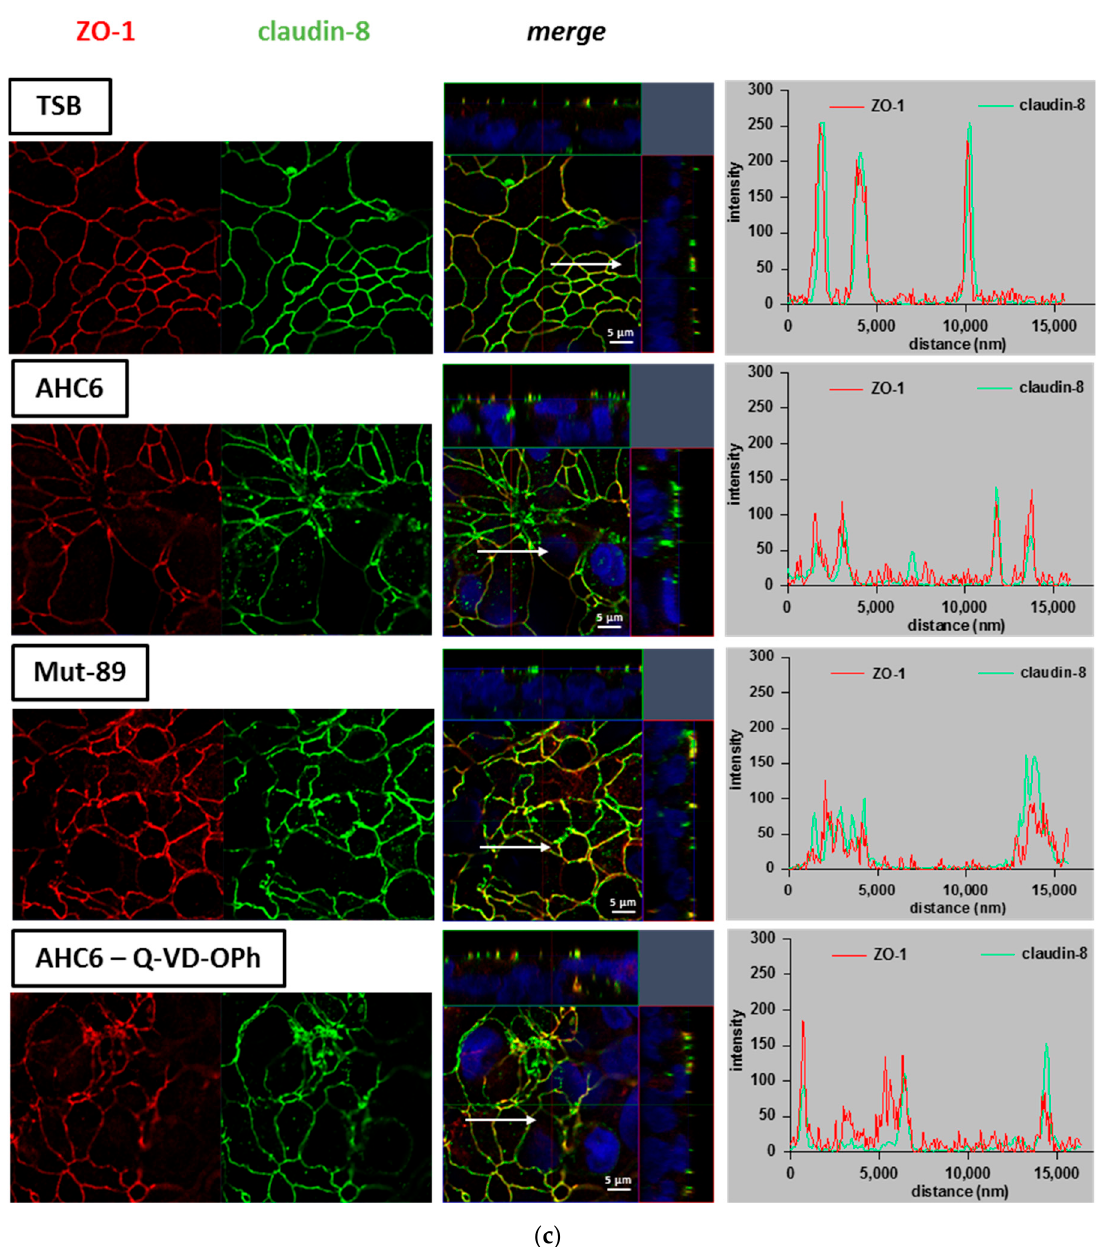
Figure 3. Redistribution of tight junction proteins in T84 monolayers. T84 monolayers were immunostained after 48 h of challenging with supernatants from AHC6, with or without previous apoptosis inhibition (Q-VD-OPh) or supernatants from Mut-89. TSB-treated monolayers served as control. Immunofluorescence staining of ( a ) claudin-1, ( b ) claudin-5, and c) claudin-8 (green) were analyzed by confocal laser scanning microscopy ( n = 3 each). ZO-1 (red) served as tight junction marker. Distribution of tight junction proteins was considered by z-stack imaging. Intensity–distance plots show the signal intensity and merging of ZO-1 and claudin signals in representative areas. Arrows were located using Zeiss Zen software and mark the range and direction of the intensity–distance plot. Nuclei were DAPI-stained (4 ′ ,6-Diamidin-2-phenylindol; blue).